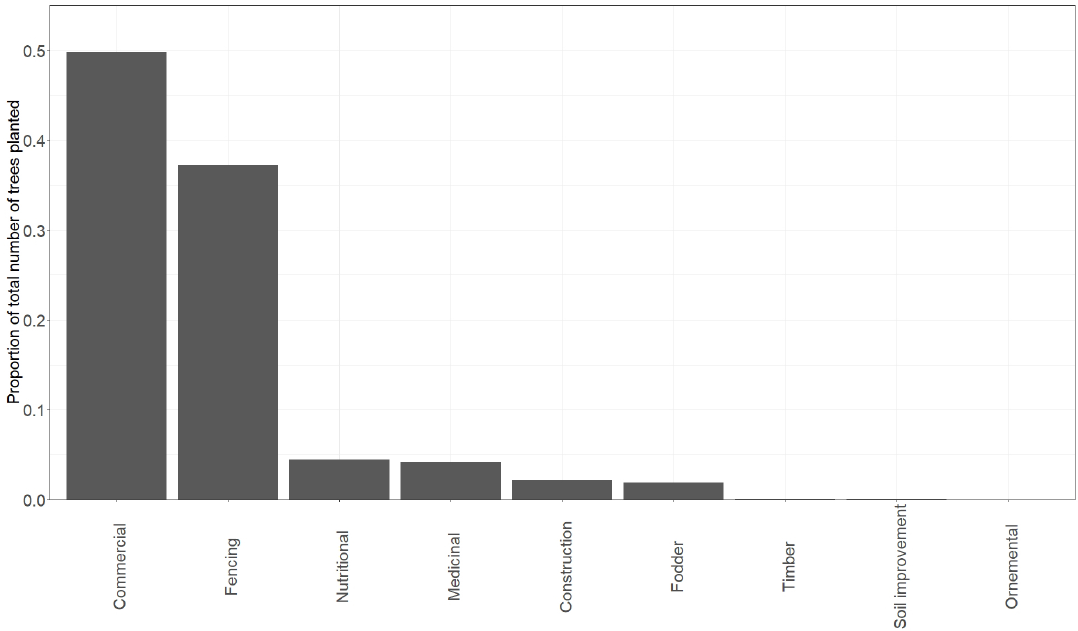
Figure 3. Proportion of trees planted according to the primary use of the species, as defined by farmers, with integration of information derived from scientific literature. The sum of all categories gives